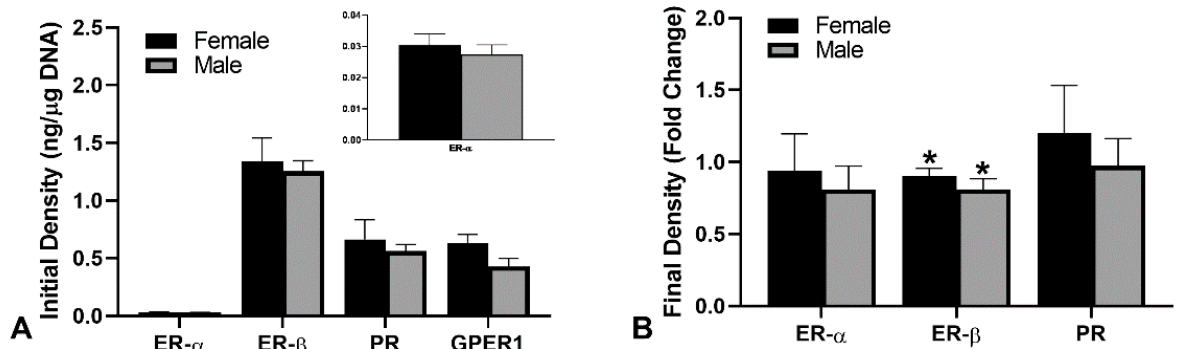
Figure 2. Receptor densities were similar in male and female cells but differ between receptor types. ( A ) initial receptor densities of the three estrogen receptors and the progesterone receptors. ( B ) After culture, the receptor densities were determined in the EDS homogenates and the fold change between vehicle control and either E 2 treated (ERs) or P 4 treated (PRs). n = 5; * indicates p < 0.05 compared to vehicle control.